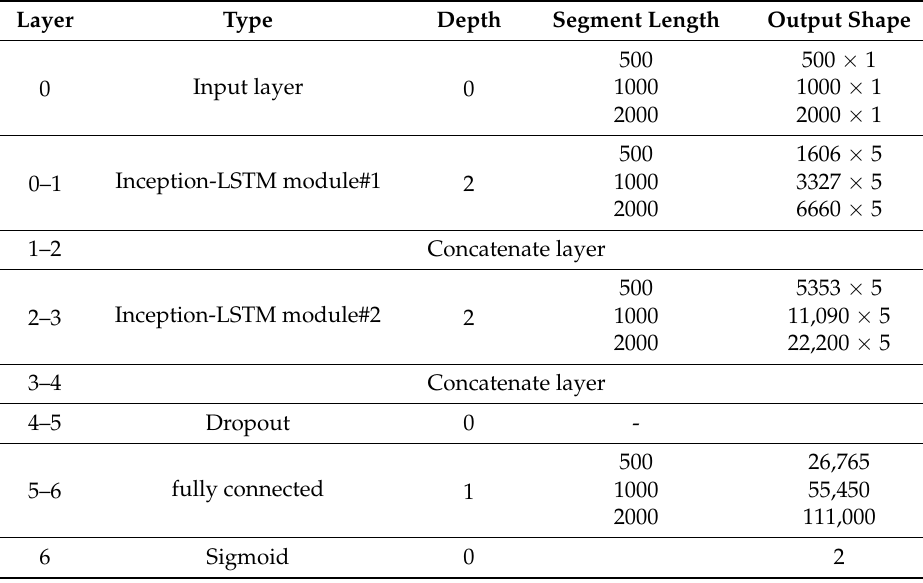
Figure 7. The details of the proposed network structure with 500 RR intervals. Table 2. The detailed structure of the proposed model.